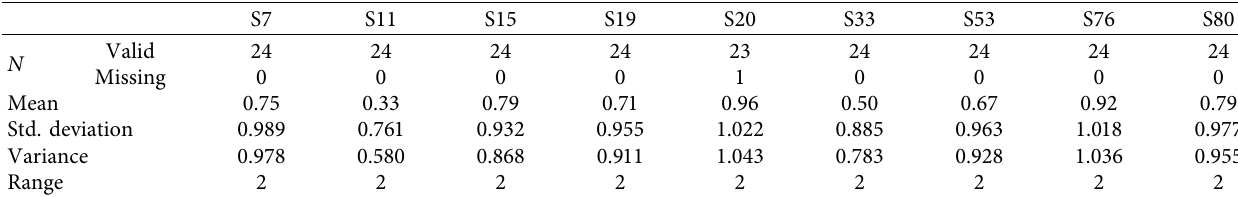
Table 8: Te antibiotic statistical